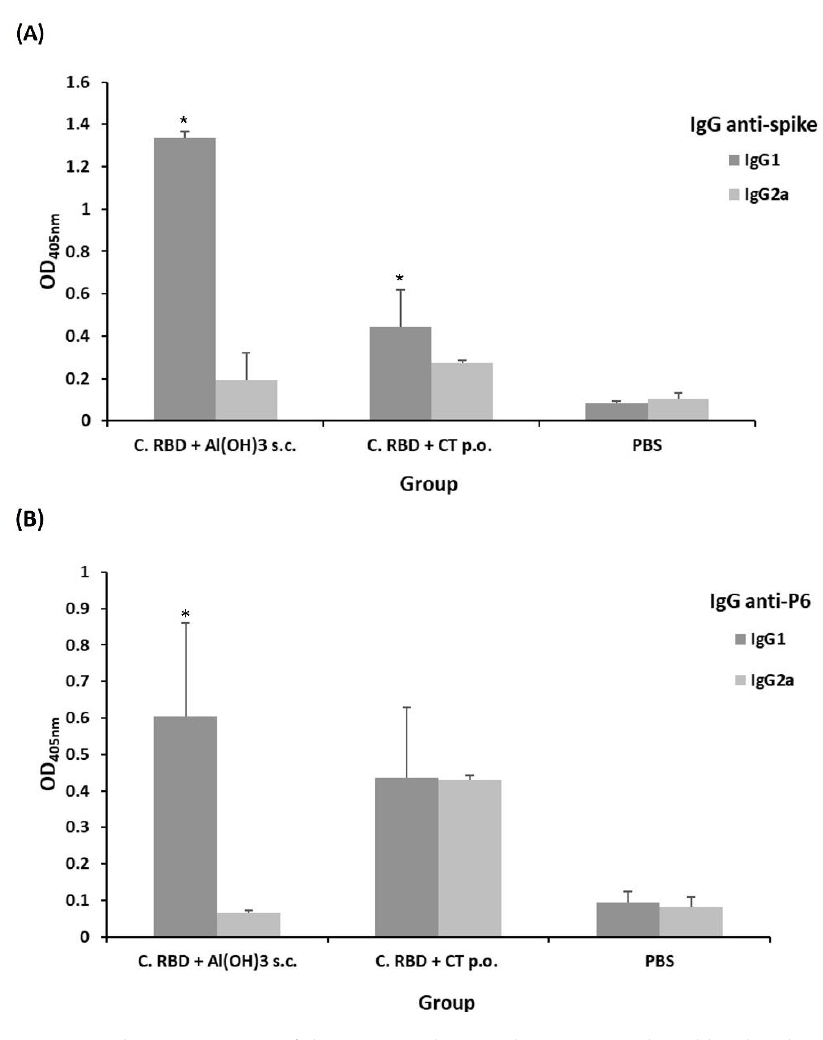
Figure 4. Characterization of the systemic humoral response induced by the algae-made RBD. The IgG subclasses, IgG1, and IgG2a were measured in serum samples (1:100 dilution) by ELISA using either spike ( A ) or P6 ( B ) as the target antigen. Error bars represent standard deviations. * denotes statistically significant differences versus the mean values of IgG2a measurements ( p < 0.05).